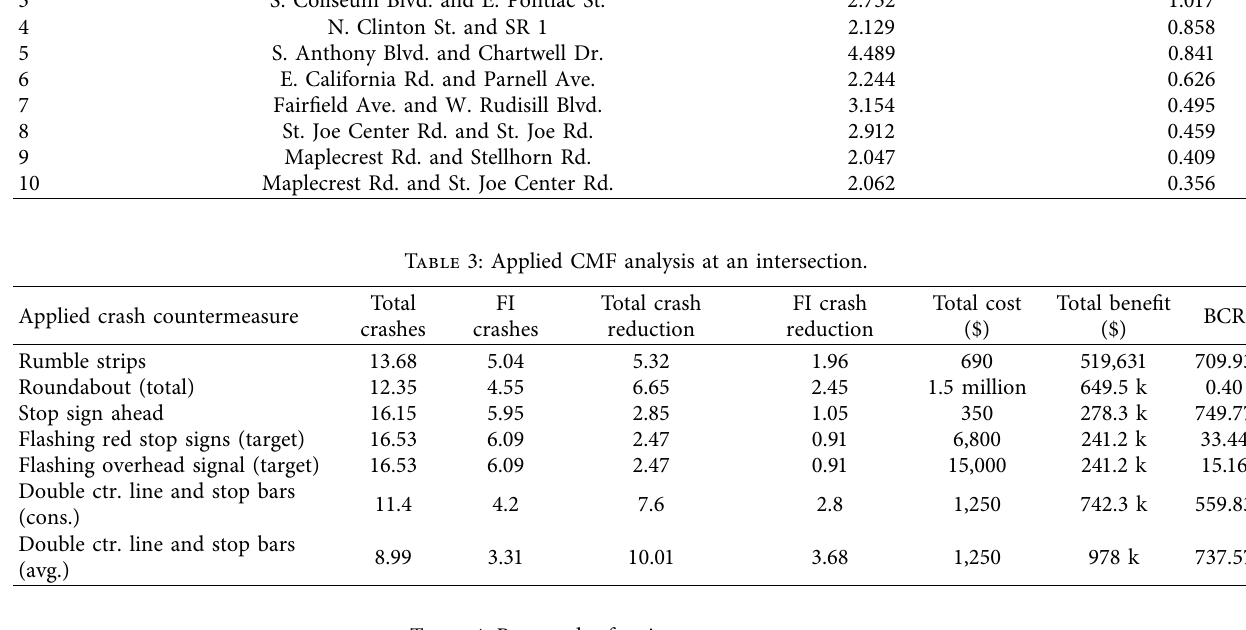
Table 4: Proposed safety improvement